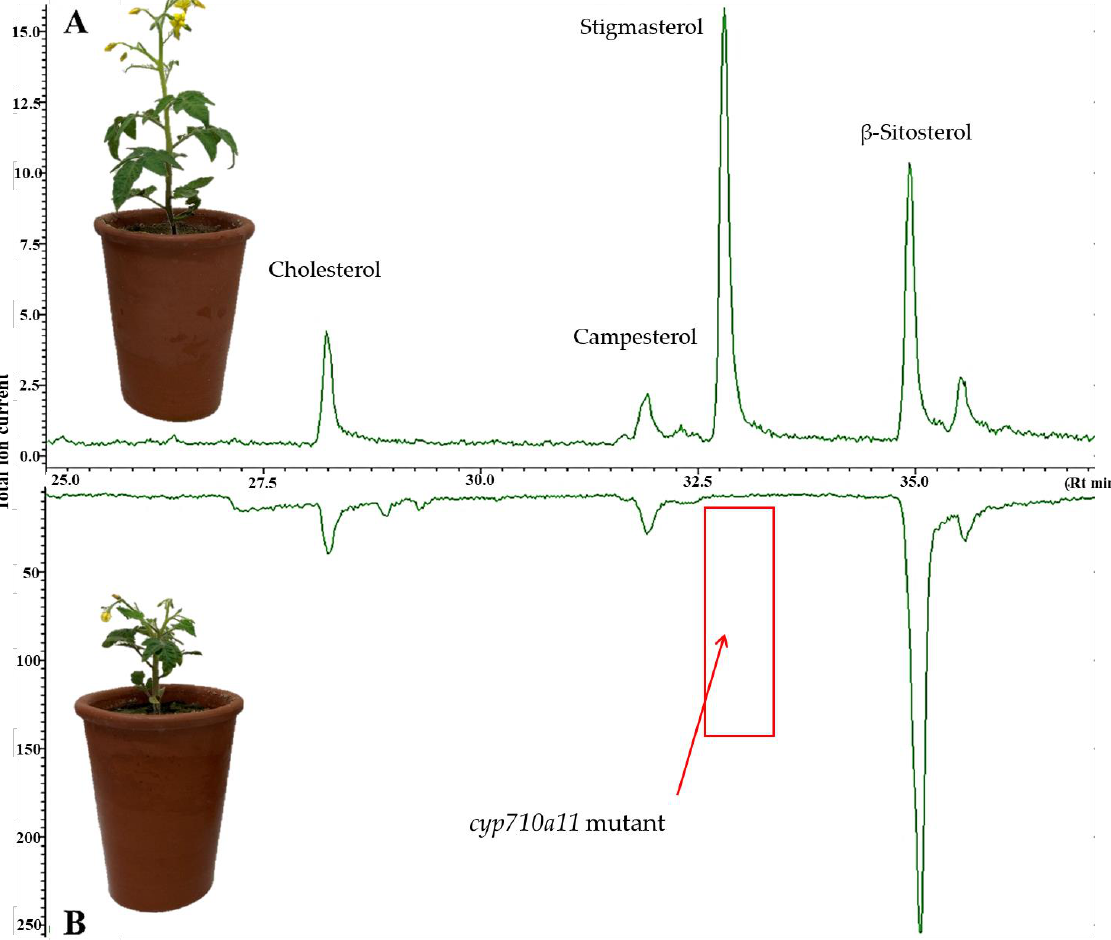
Figure 2. Chemical characterization of the sterol compositions of the wt ( A ) and the cyp710a11 knockout mutant ( B ) of tomato cv. Micro-Tom by gas chromatography–mass spectrometry. The loss of stigmasterol in the cyp710a11 knockout mutant plant is indicated by a red box in the representative MS chromatogram shown here (green line).